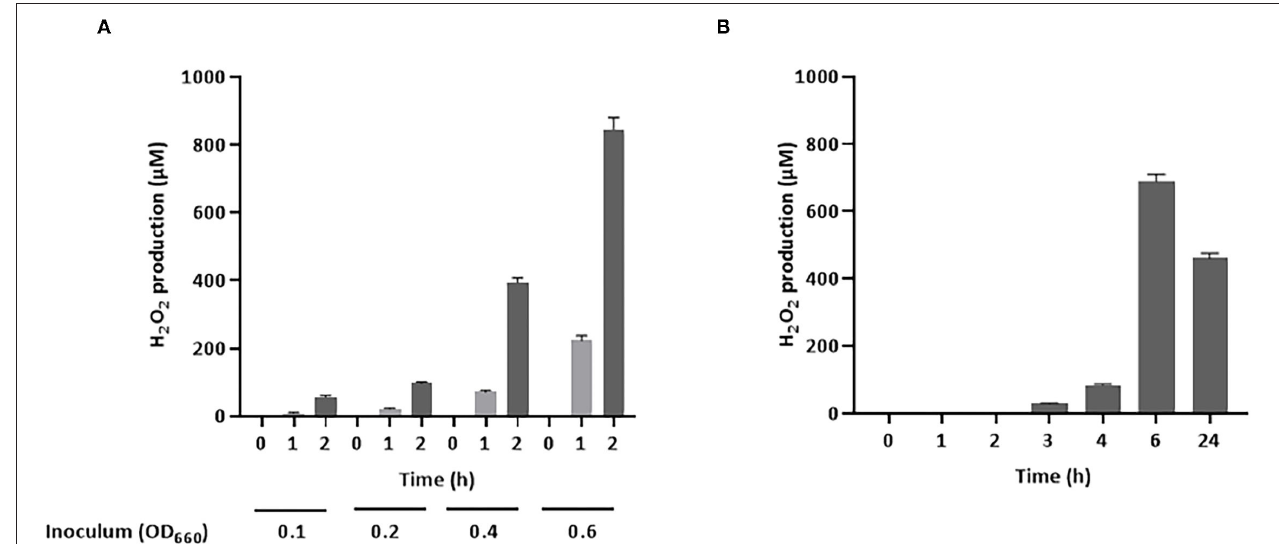
FIGURE 1 | Production of H 2 O 2 by S. pluranimalium 2N12. (A) : Dose- and time-dependent effect. (B) : Time-dependent effect. H 2 O 2 was quantified using a fluorimetric assay. Assays were performed in triplicate in two independent experiments, and the means ± SD were calculated.